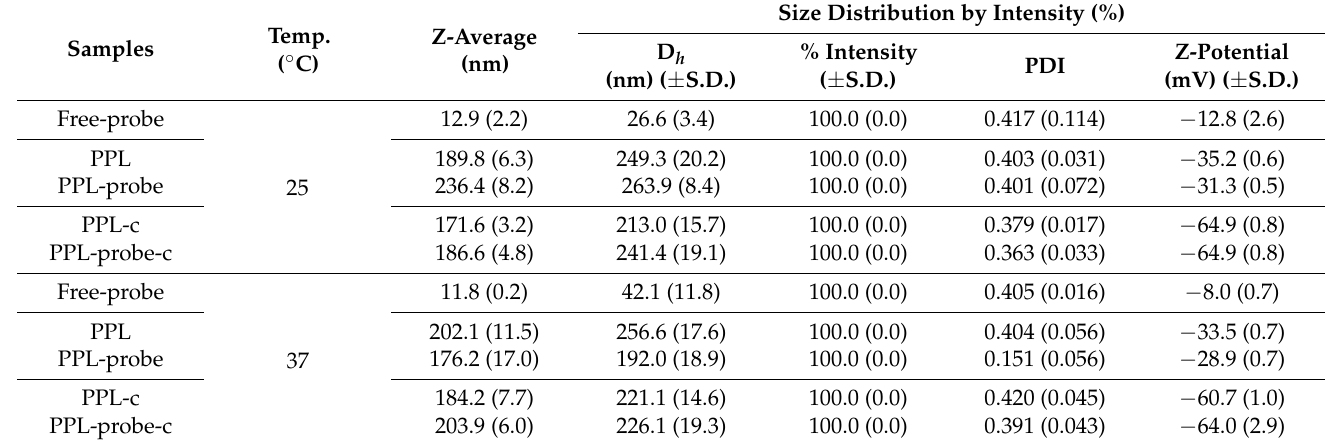
Table 1. Hydrodynamic diameter (D h ), size distribution (PDI), and Z-potential of free-probe (50 µ g/mL), free-PPL and PPL-probe post-incubation (PPL and PPL-probe), and post-incubation and purification (PPL-c and PPL-probe-c) by vesicular exclusion column (VEC) as measured by DLS